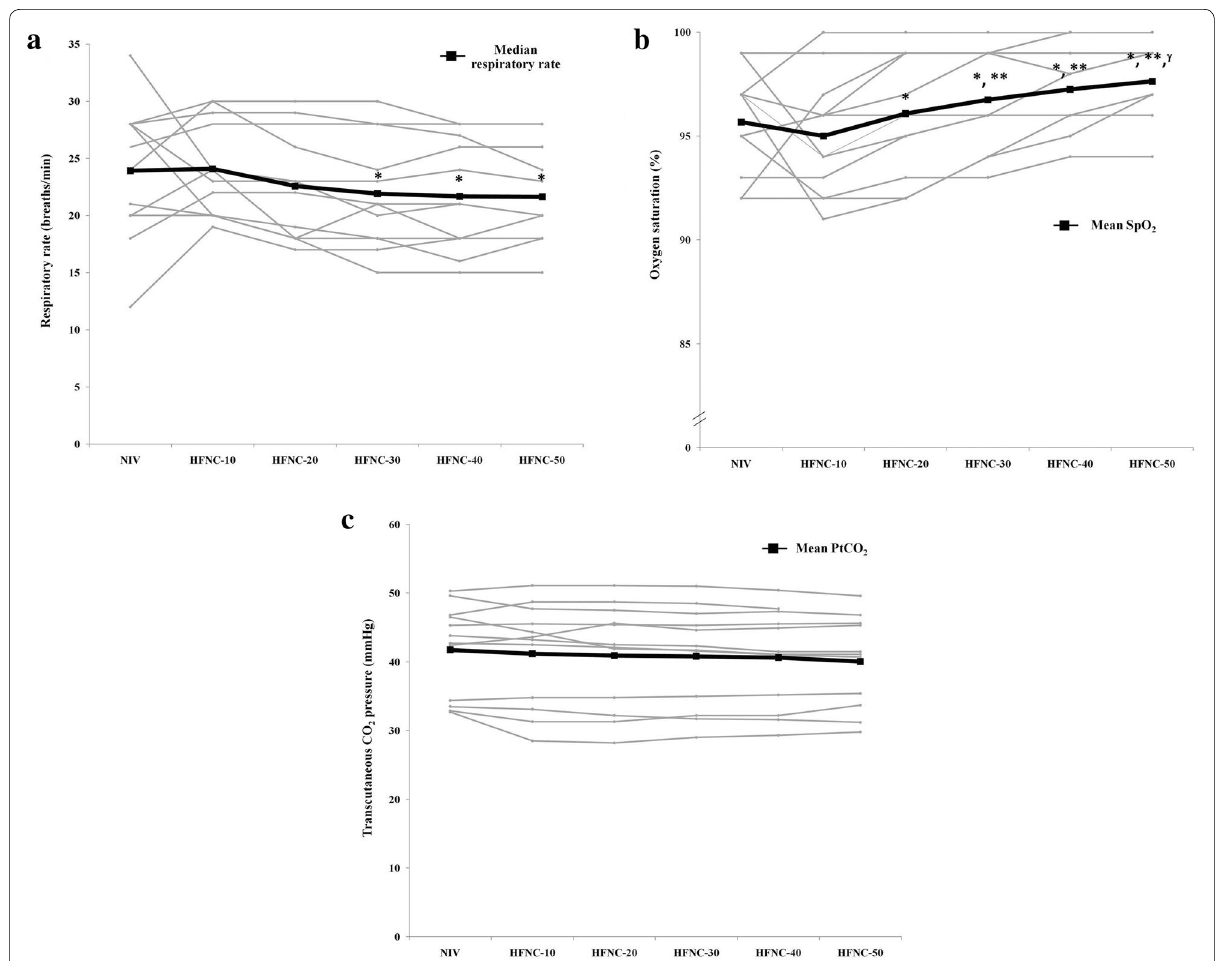
Fig. 3 Individual data of a respiratory rate, b oxygen saturation (SpO 2 ), and c transcutaneous CO 2 pressure (PtcCO 2 ) during non-invasive ventilation (NIV) and high-flow nasal cannula (HFNC) at different flow rates. *Indicates p < 0.05 compared with HFNC at a flow rate of 10 L/min, **Indicates p < 0.05 compared with HFNC at a flow rate of 20 L/min, γ Indicates p < 0.05 compared with